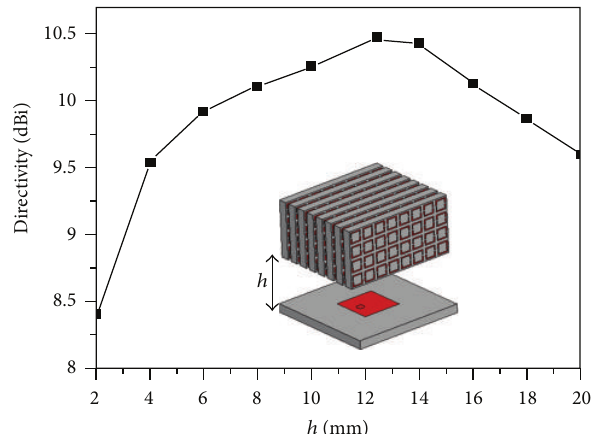
Figure 12: Directivities of the patch antenna with LHM superstrate located at different distance.